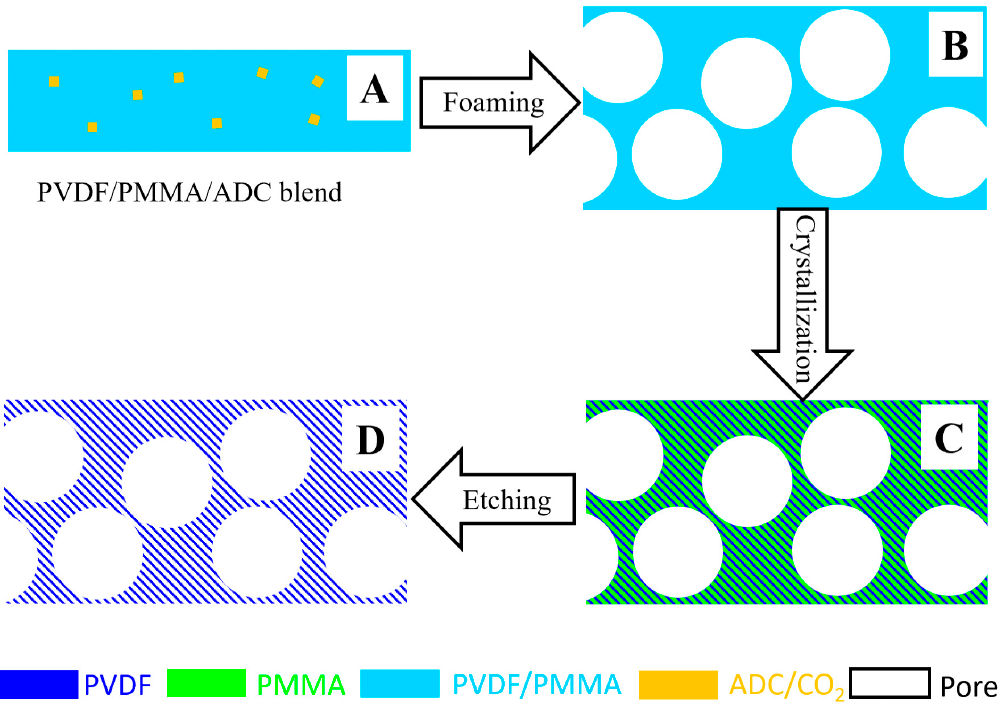
Figure 1. Illustration of fabrication of PVDF HPMs via the combination of crystallization template and foaming. The specimen of hot-pressed PVDF/PMMA/ADC blend ( A ), upon foaming ( B ), isothermal crystallization ( C ) and etching ( D ).